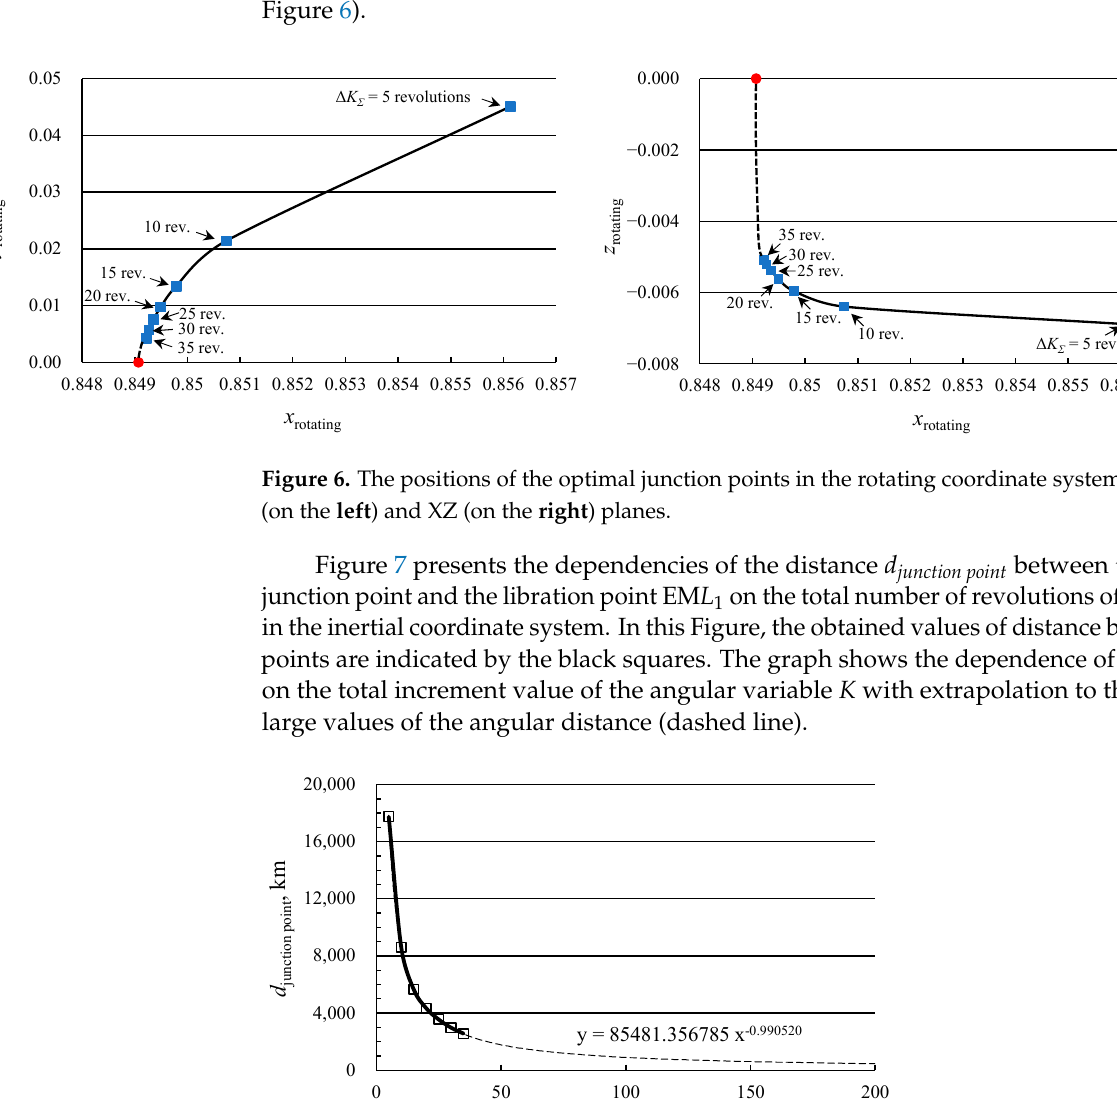
Table 4. Parameters of the initial GTO and final elliptical lunar orbit.